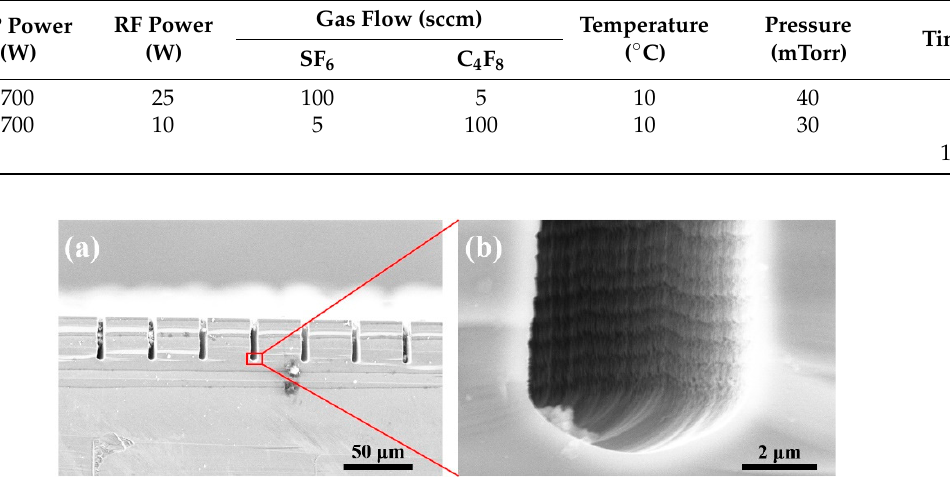
Table 1. Bosch process etching parameters.